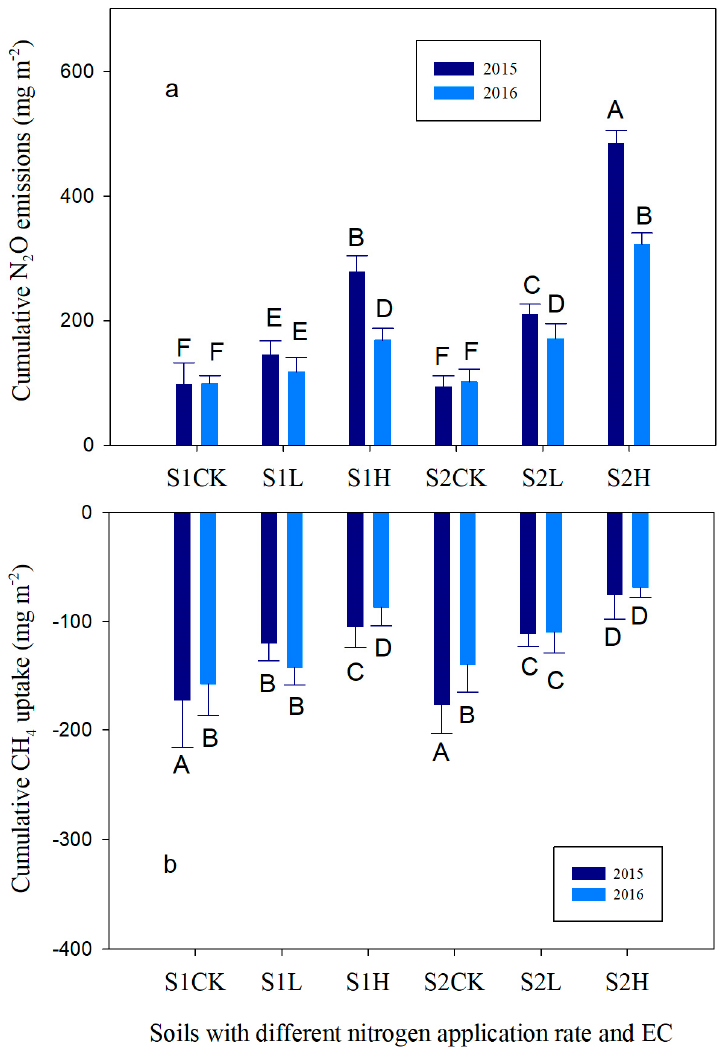
Figure 4. Cumulative N 2 O emissions ( a ) and cumulative CH 4 uptake ( b ) in the S 1 and S 2 with three levels of nitrogen fertilization (H, L, and CK) in saline soil from 2015 to 2016. Vertical bars indicate the mean and standard error. There was significant difference for different letters (A–F) ( p < 0.01). (S 1 : slightly saline soil; S 2 : strongly saline soil).